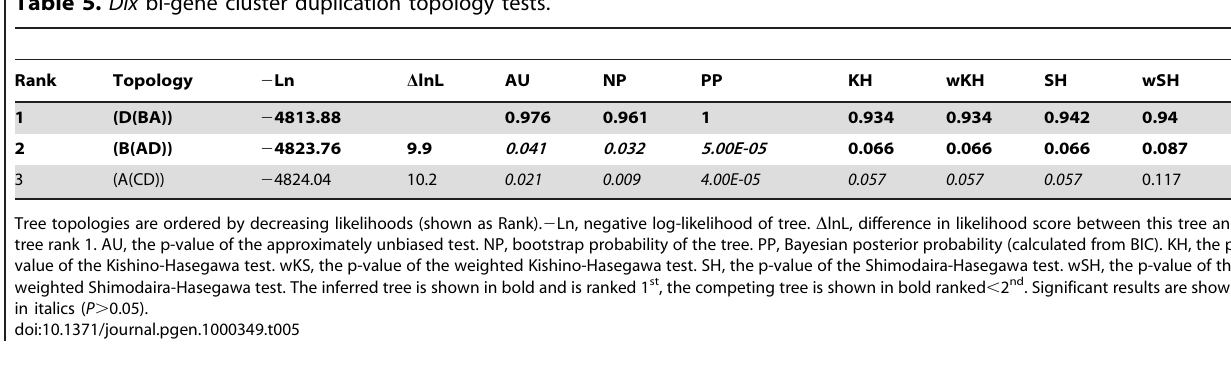
Table 5. Dlx bi-gene cluster duplication topology